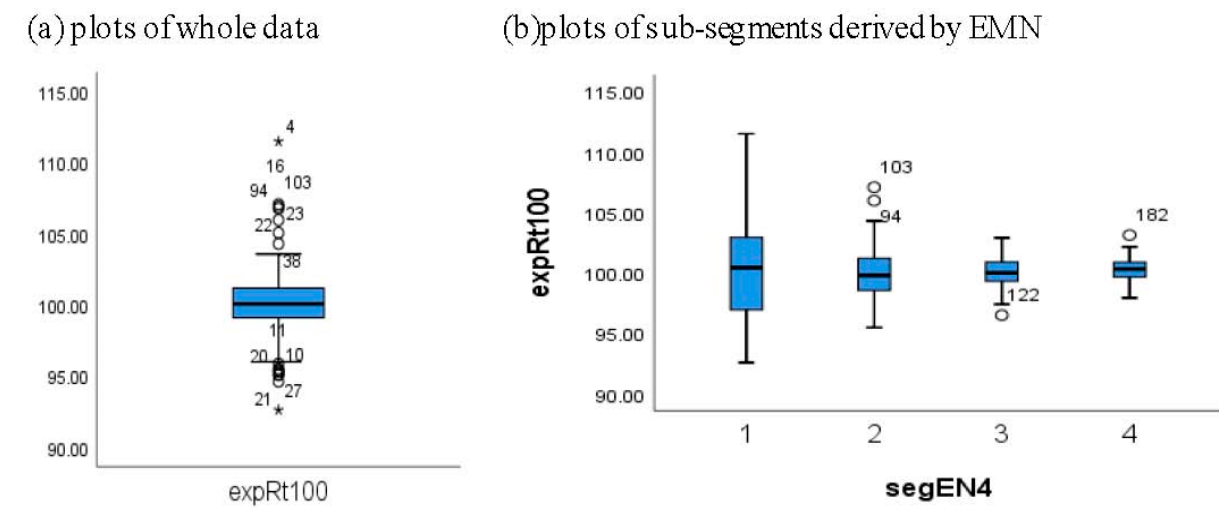
e R with the whole data, and ( b ) the four sub-segments derived by EMN. t